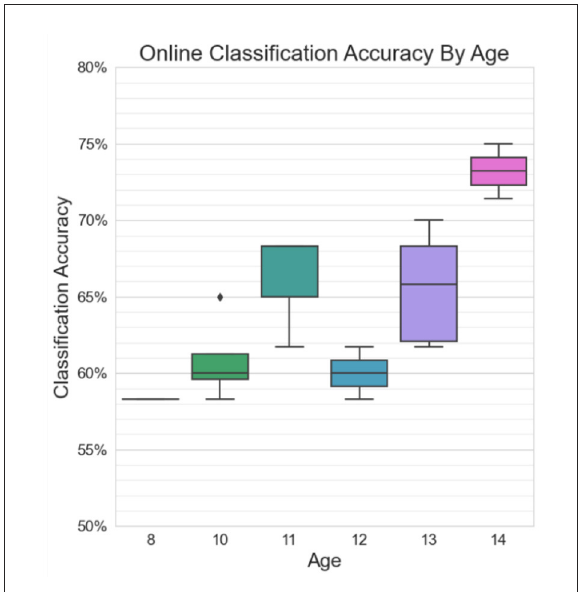
FIGURE11 Classification accuracies in excess of chance for online sessions, grouped by age. There is a moderate significant positive correlation between age and BCI performance ( r = 0.63, p =